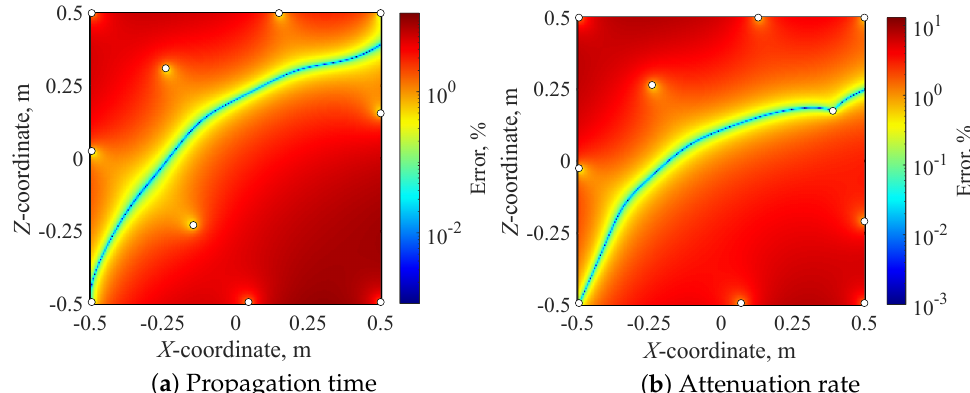
Figure 10. Distributions of error in the sound source grid estimated by IDW interpolation ( p = r , 10 sampling points).